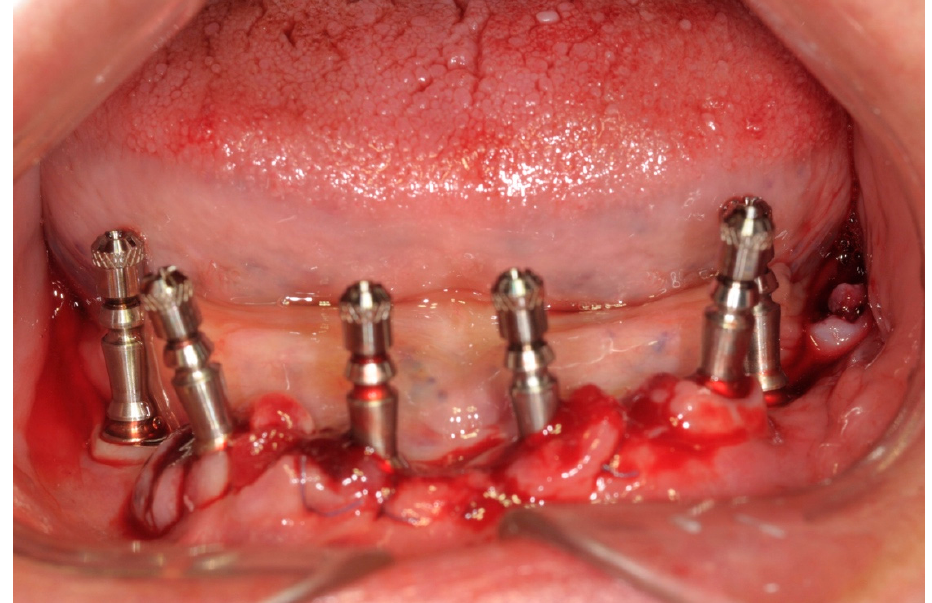
Figure 5. Transfer abutments before impressions.